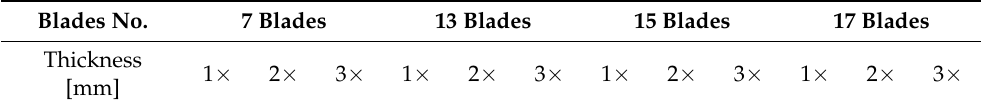
Figure 2. Modelling representation of the thickened blades shape and their intersection with the peak flow channel curve for the 17 blades impeller: ( a ) blade model 1 × ; ( b ) blade model 2 × ; ( c ) blade model 3 × . Table 2. Varying the number of blades and their